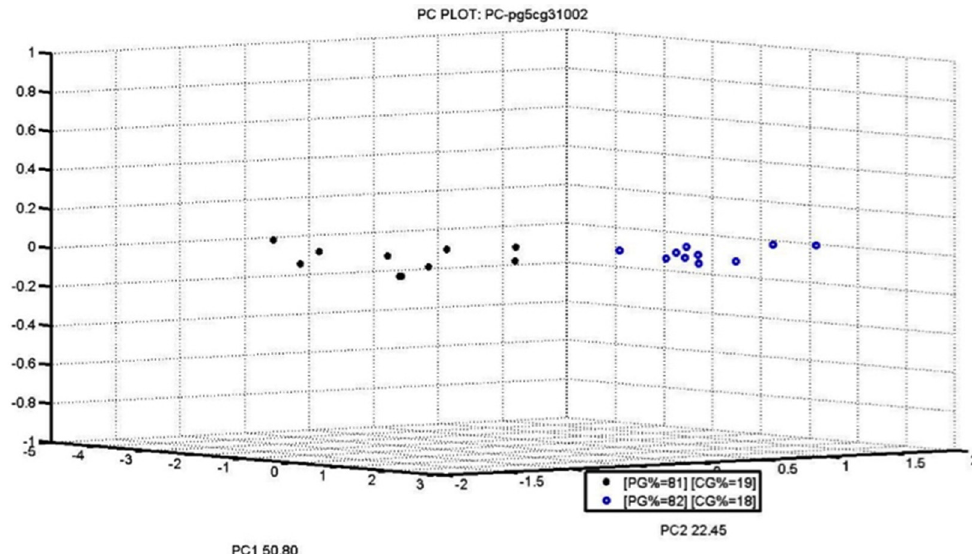
Figure 4. PCA Score PLOT for two different analyzed percentages (18% and 19%).